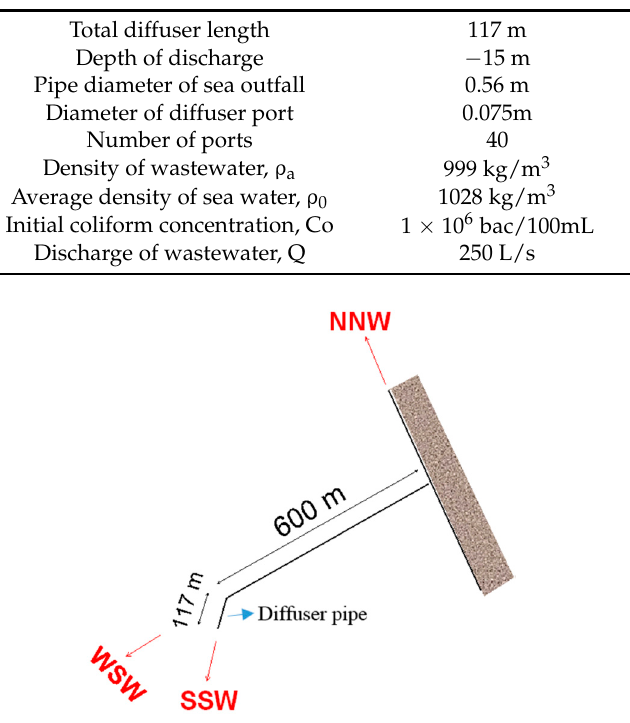
Figure 12. The effect of wastewater discharge on near-field dilution [20].